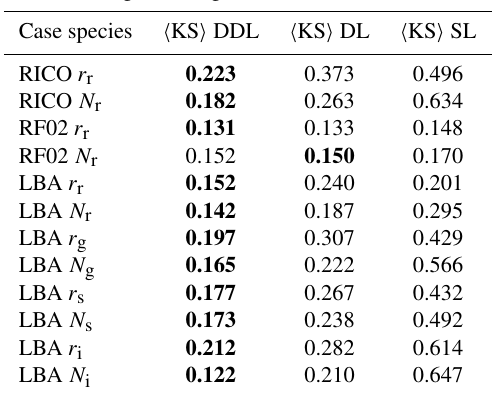
Table 1. Kolmogorov–Smirnov statistic averaged over multiple grid levels and statistical output timesteps comparing each of DDL, DL, and SL hydrometeor PDF shapes to SAM LES results. The best (lowest) average score for each case and hydrometeor species is listed in bold. The DDL has the lowest average score most often, and the DL has the second-lowest average score most often.